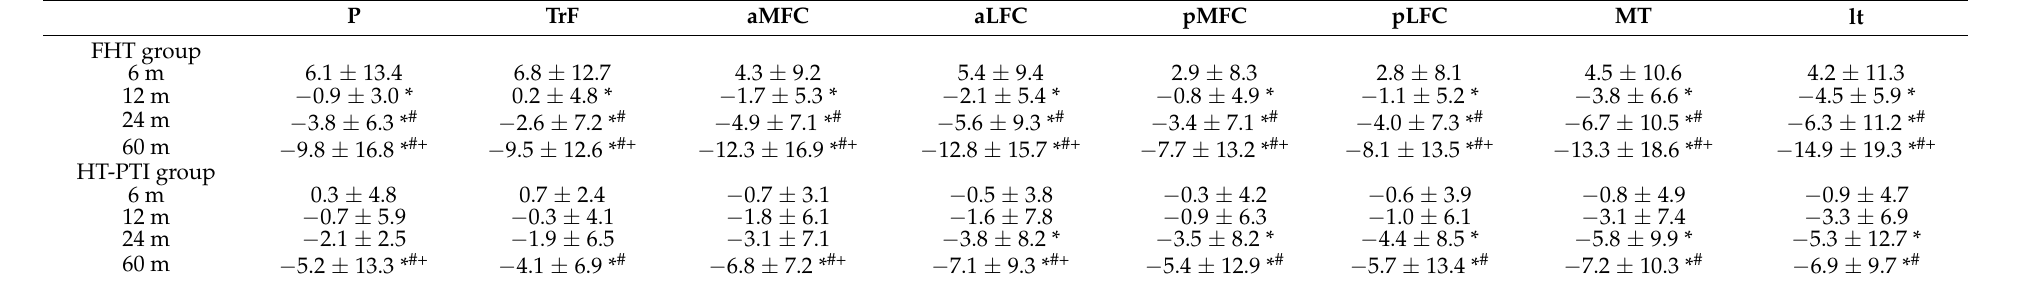
Table 3. CV% at Different Subregions and Timepoints in Two Groups α